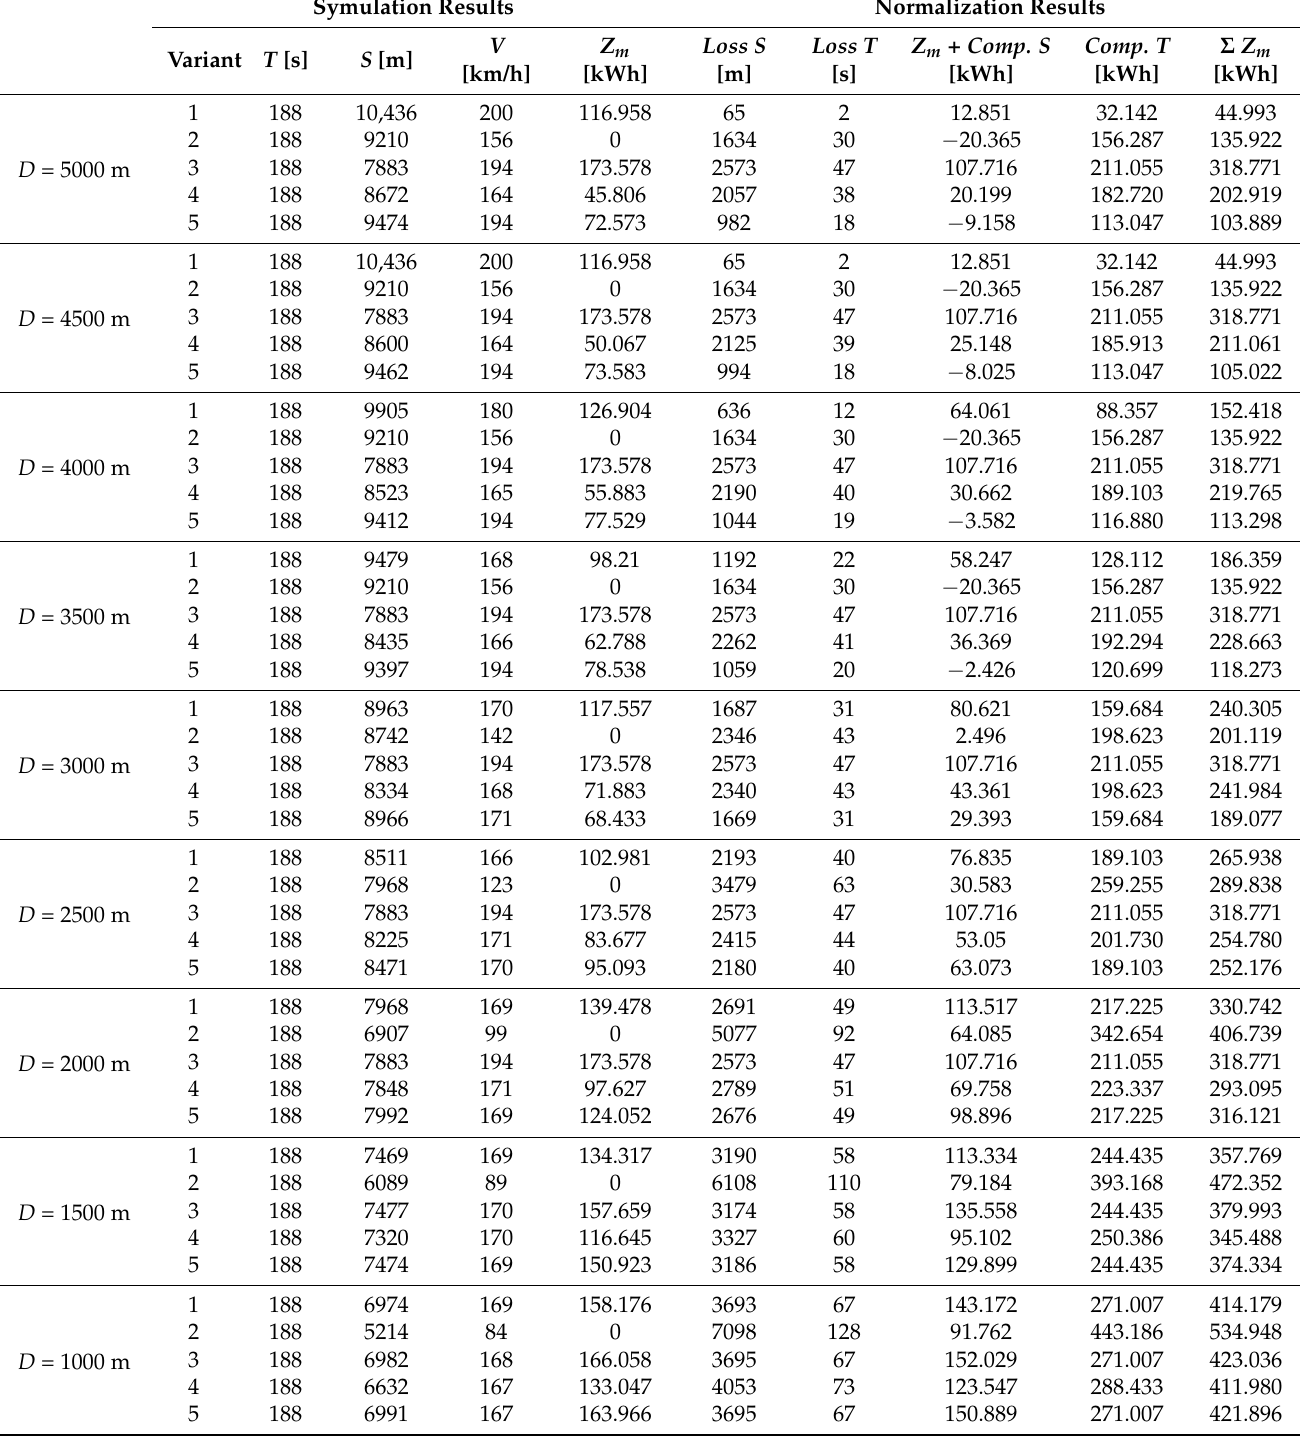
Table 3. Simulation results for context